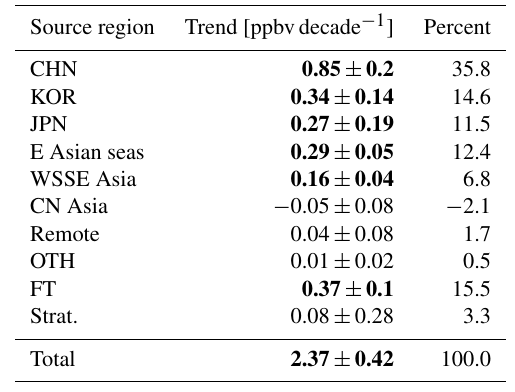
Table 1. Summary of the linear trends in annual mean tagged O 3 tracers as well as the total O 3 averaged over Japan (JPN-ALL) for 1980–2005. Bold figures denote that trends are significant at 5% risk level.